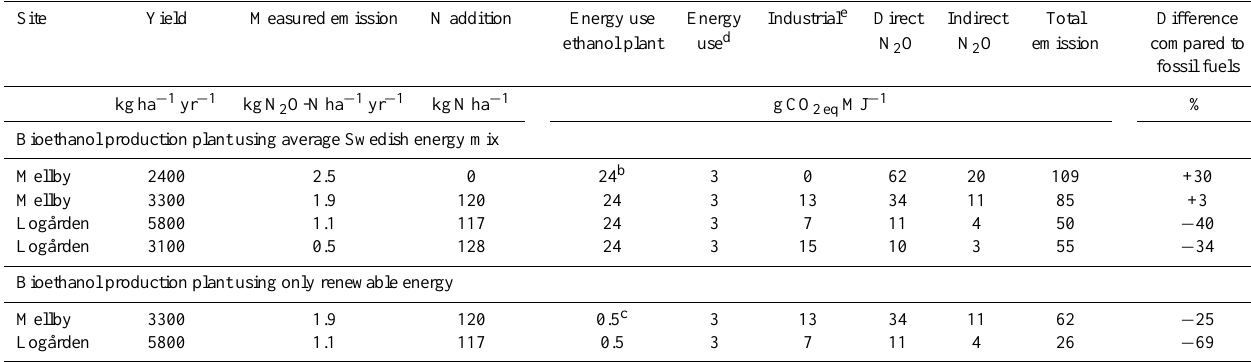
Table 3. LCA applied to Mellby and Log˚arden data, showing GHG saving possibilities compared to fossil fuels a .